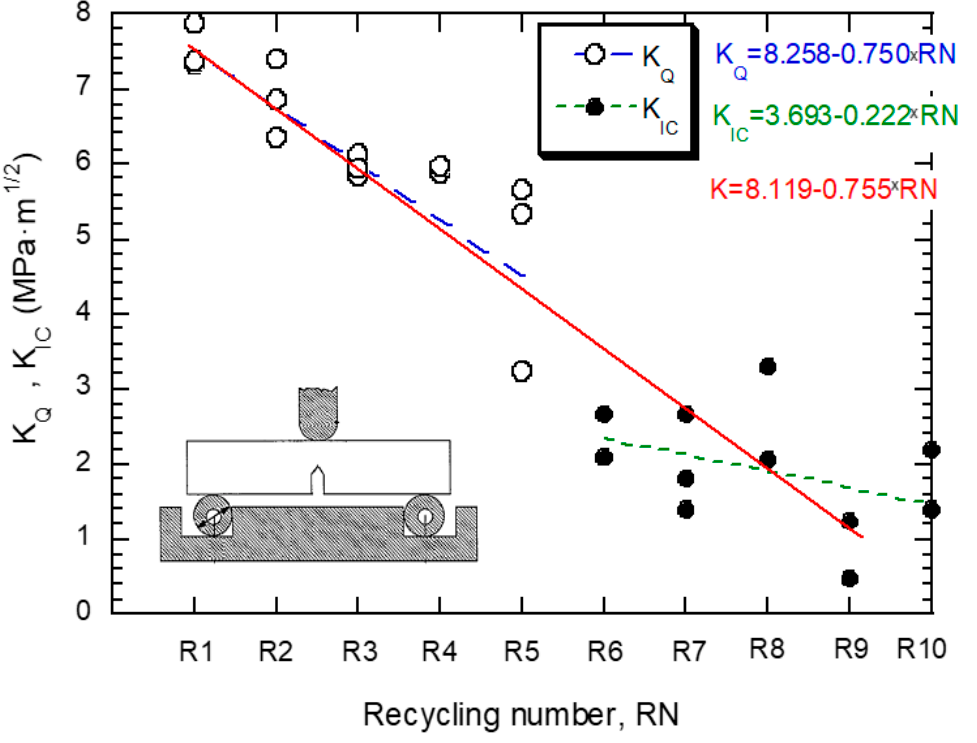
Figure 9. Evolution of fracture toughness with the number of recyclings. Table 7. Summary of results obtained from the linear fitting (Y = β 0 + β 1 ·X) of the fracture toughness, K Q or K Ic . The coefficients β 0 and β 1 ·are accompanied with their 95% confidence bounds.